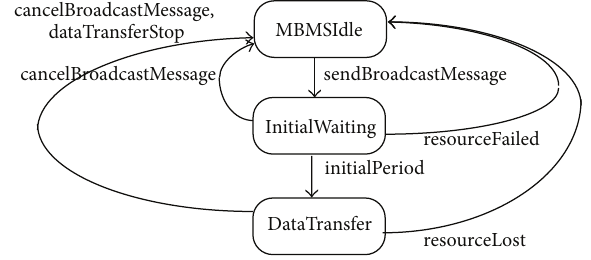
Figure 6: MBMS session state